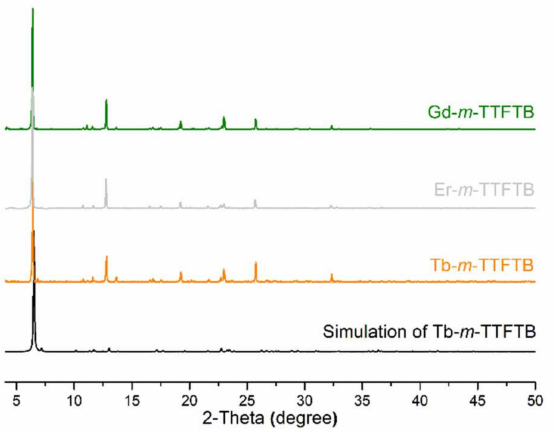
Figure 2. Experimental and calculated powder X-ray diffraction patterns for Tb- m -TTFTB, Er- m - TTFTB, and Gd- m -TTFTB. PXRD was simulated based on the single-crystal structure of Tb- m -TTFTB by applying preferred orientation along the b